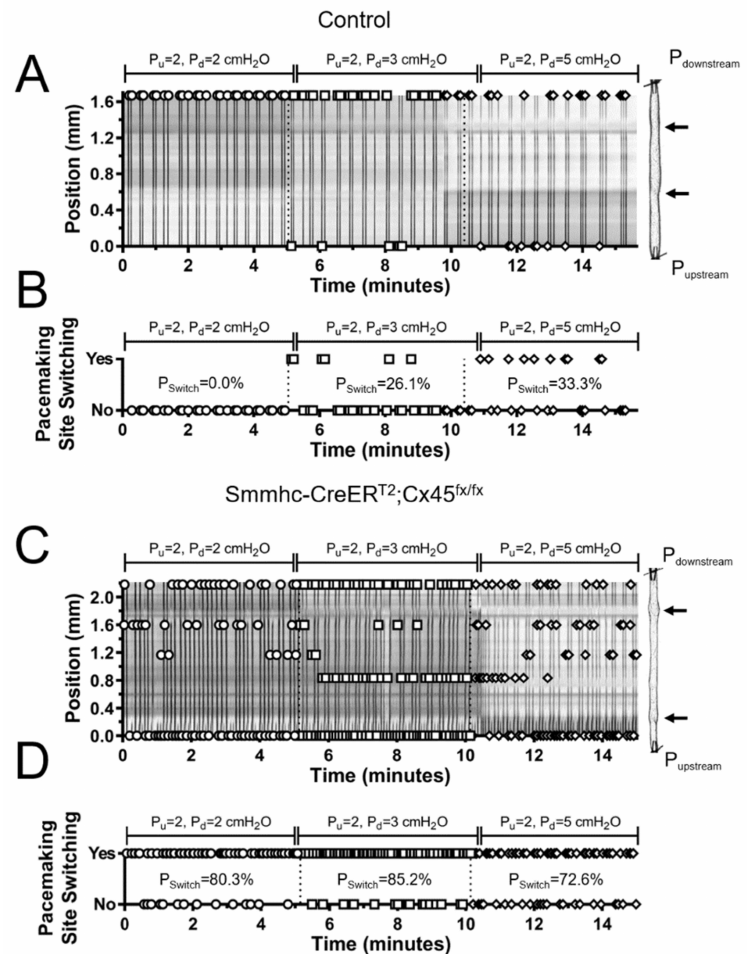
Figure 7. Pacemaking activity in lymphatic vessels from control (C57BL / 6J WT and Cx45 fx / fx ) and LMC Cx45-deficient (Smmhc-CreER T2 ; Cx45 fx / fx ) mice under di ff erentially increased downstream (downstream) intraluminal pressure (P downstream > P upstream ): ( A , C ) STMs of contractions of popliteal lymphatic vessels recorded over 15 minutes from control and Cx45-deficient animals. Di ff erent combinations of various upstream–downstream pressure levels (denoted as P u and P d respectively) were tested over periods of 5 minutes each. Vessel images are aligned to the right sides of the two-dimensional maps (dark arrows indicate valve location). Pacemaking sites are represented by open circles; ( B , D ) Pacemaking site switching determined after comparing where consecutive contractions were initiated. Comparison is performed one-by-one for all contractions in the STMs shown in A and C. Switching probability (P Switch ) is displayed for each given example and for each given di ff erential pressure